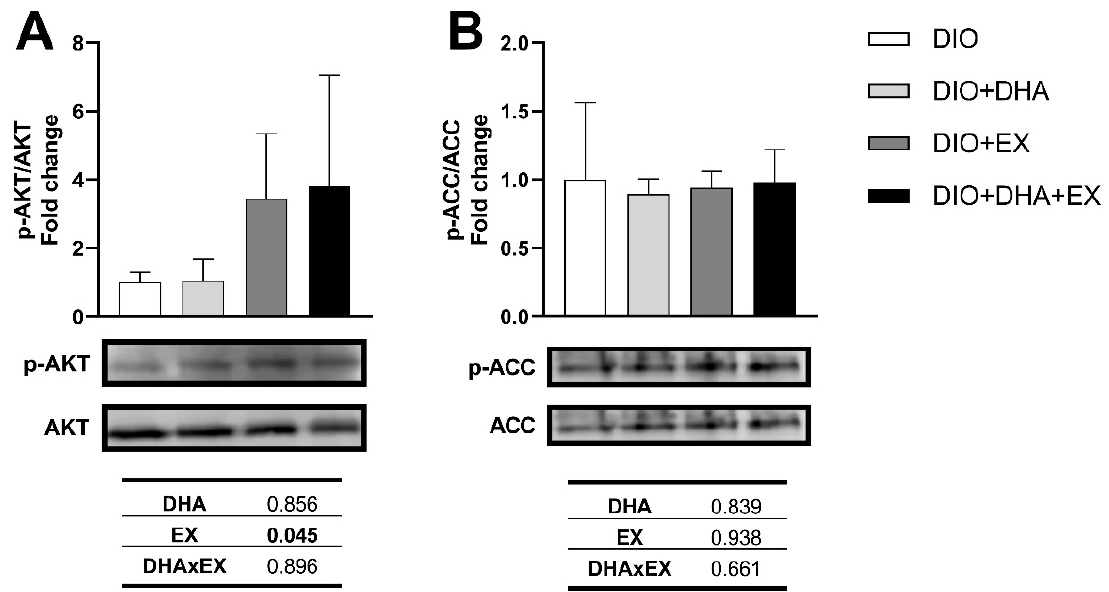
Figure 4. Representative Western blot and densitometry analysis of the effects of long-term DHA supplementation and/or exercise training on phosphorylated AKT and total AKT ( A ) and phospho- rylated ACC and total ACC ( B ) in the gastrocnemius muscle of 18-month-old DIO female mice. Band densities of phosphorylated AKT and phosphorylated ACC were normalized by total AKT and total ACC, respectively. Data presented as mean (SD); n = 3–4. The p values for the main factors, DHA supplementation (DHA), exercise (EX) and the interaction between both (DHAxEX) are shown in the corresponding rows of the tables below the figures. Statistically significant p values are marked in bold.